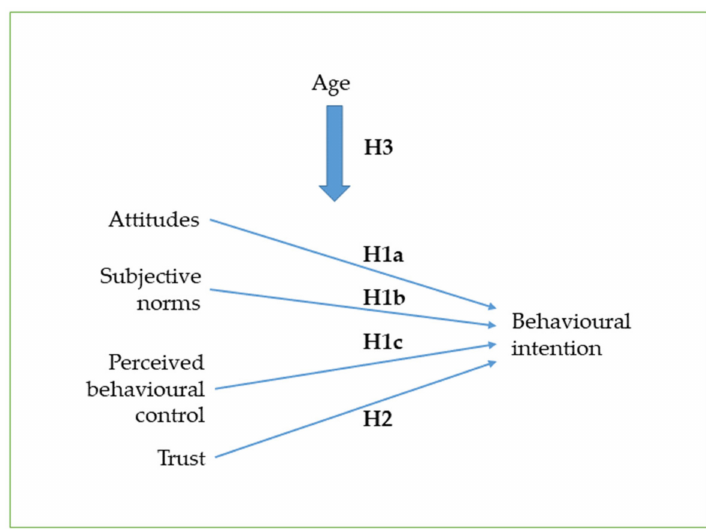
Figure 1. The conceptual model of the